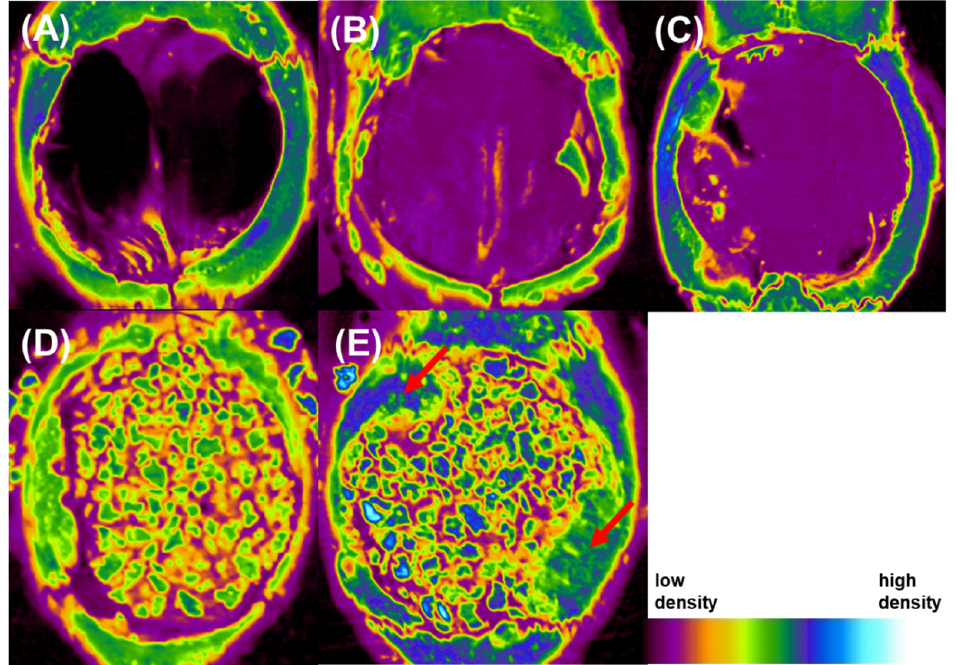
Figure 13. BMD images ( A ) defect group, ( B ) GS group, ( C ) GS + DFAT group, ( D ) α -TCP/GS group, and ( E ) α -TCP/GS + DFAT group BMD, bone mineral density; α -TCP/GS, composite gelatin sponge; GS, gelatin scaffolds; and DFAT, dedifferentiated fat cell. The red arrows indicate new